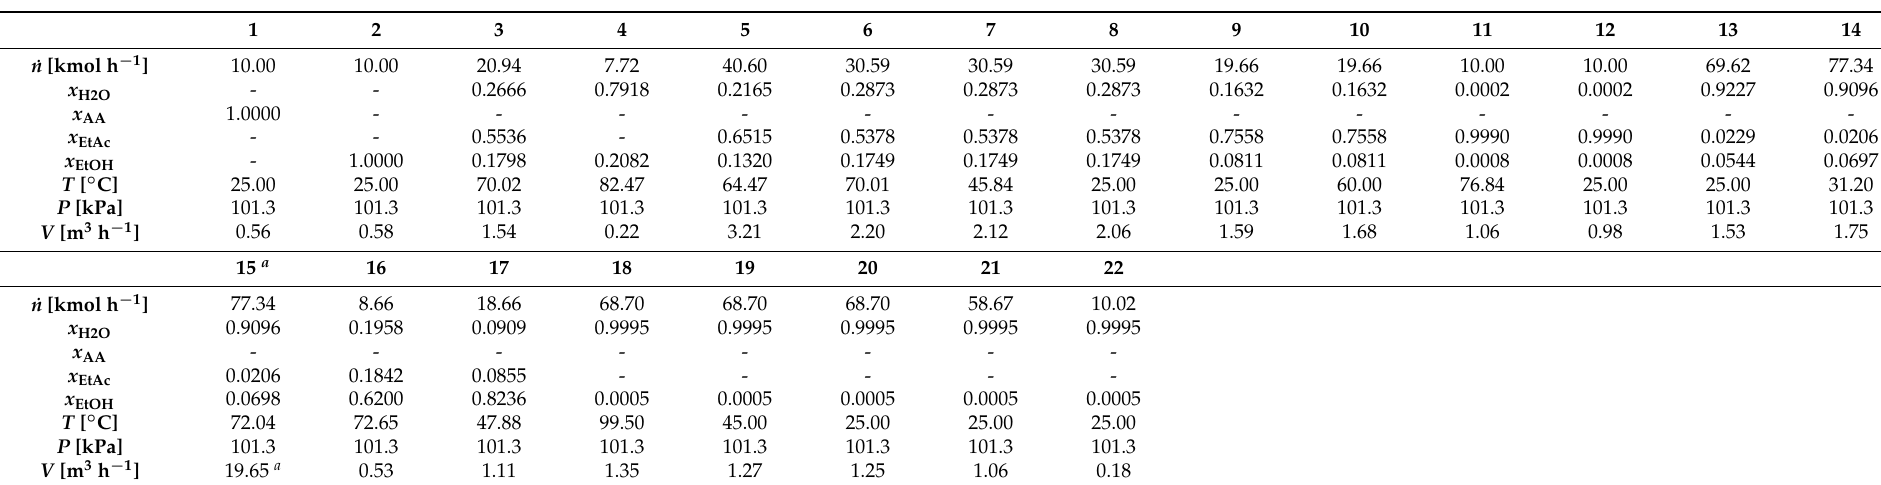
Table A3. Material balance of designed RD column with a separation unit (Figure 3) adapted from our previous work [5]; Material balance of designed RD column with a separation unit and an MVRHP (Figure